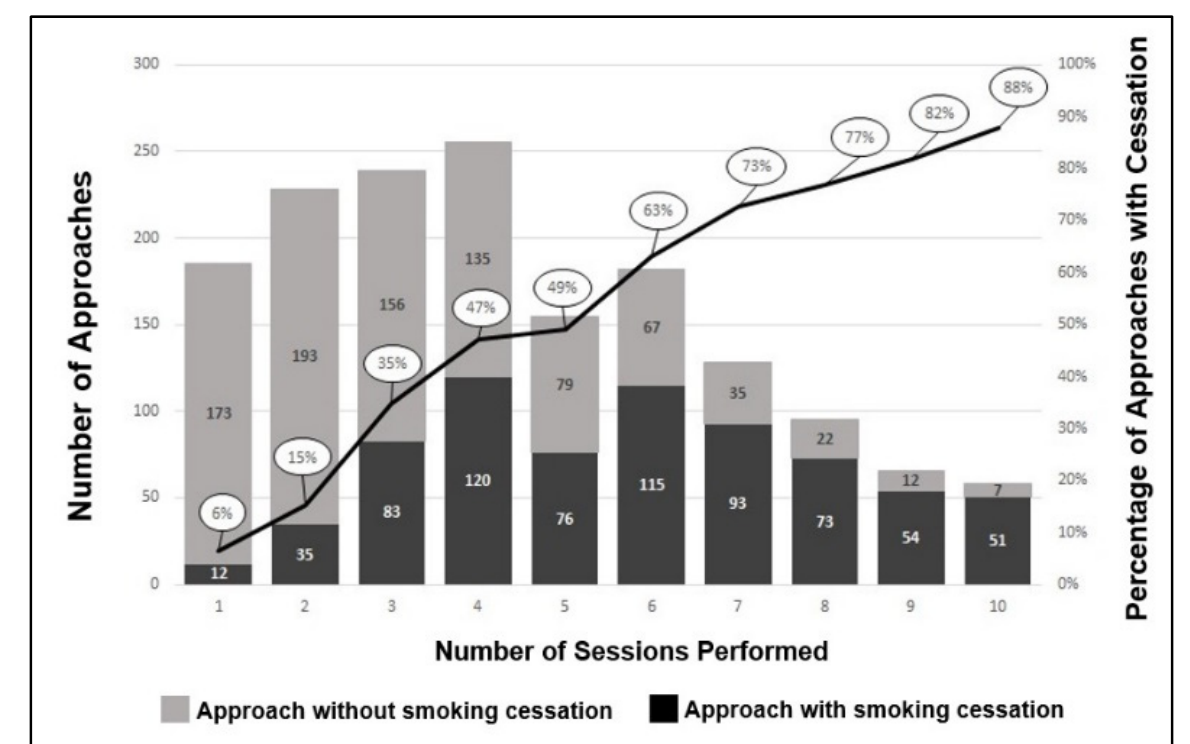
Figure 2. Incidence of smoking cessation in the pharmaceutical service with group approaches. 2018–2019. Belo Horizonte—MG. Brazil. Table 1. Factors associated with smoking cessation according to univariate and multivariate analyses. 2018–2019. Belo Horizonte—MG.